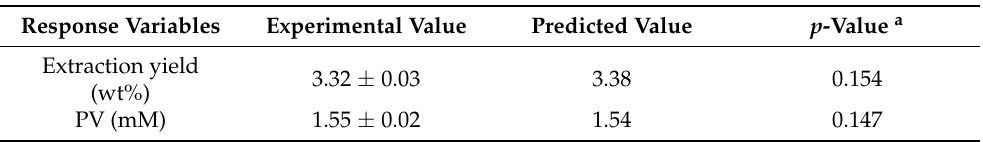
Table 4. A comparison between the experimental and predicted values for the response variables at optimal conditions of extraction yield and PV of silkworm pupae oil. Response